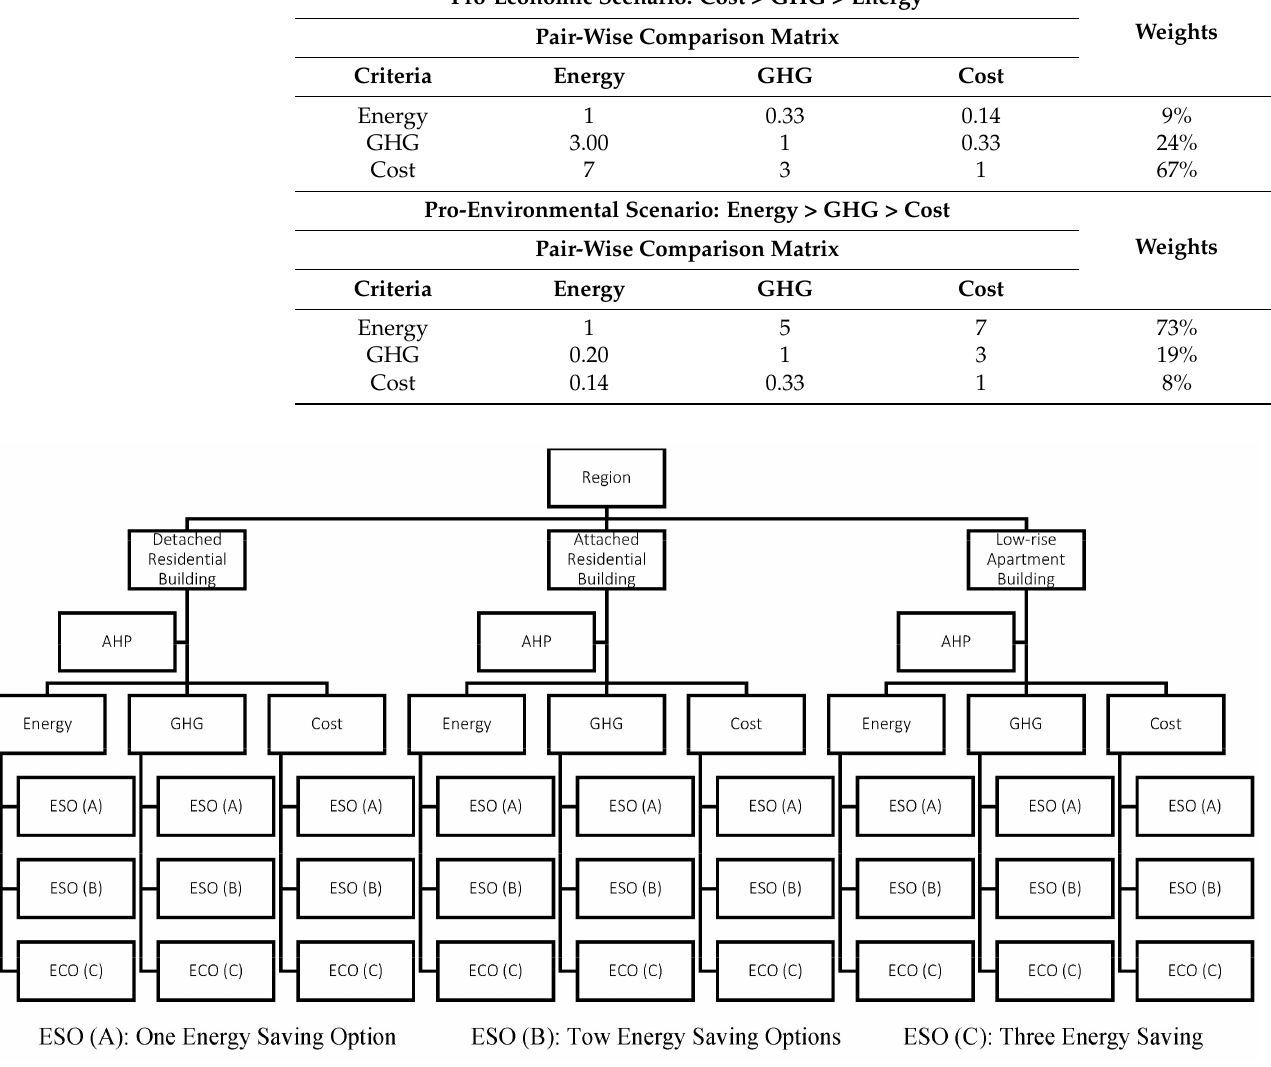
Figure 4. Weighting scenarios based on AHP in the residential building, Saudi